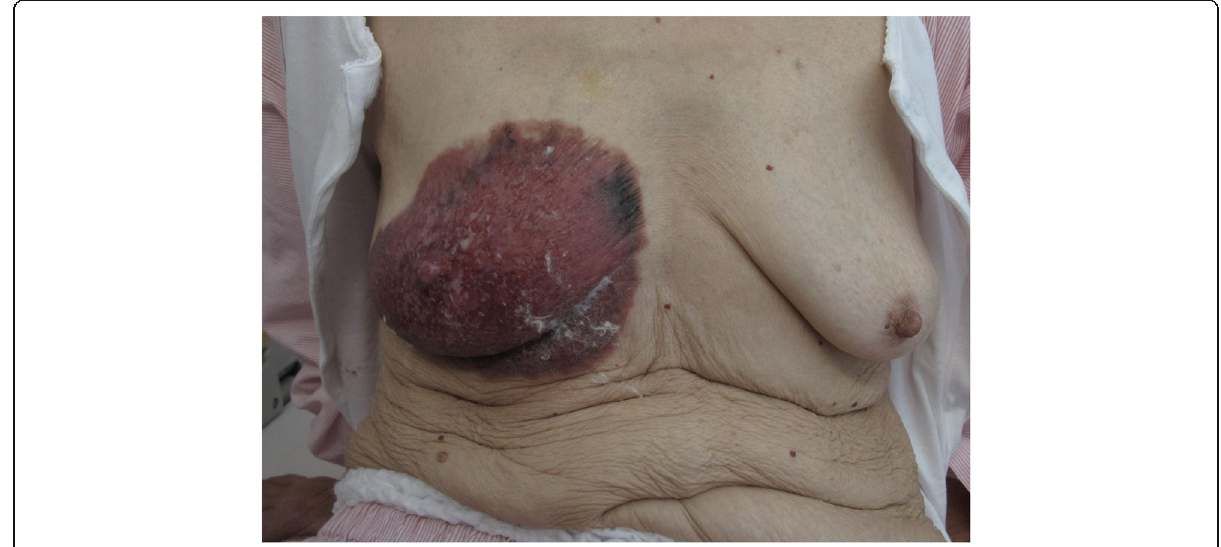
Fig. 1 Macroscopic view of the right breast. The area of the tumor was 15 × 15 cm 2 with erythema and a localized skin